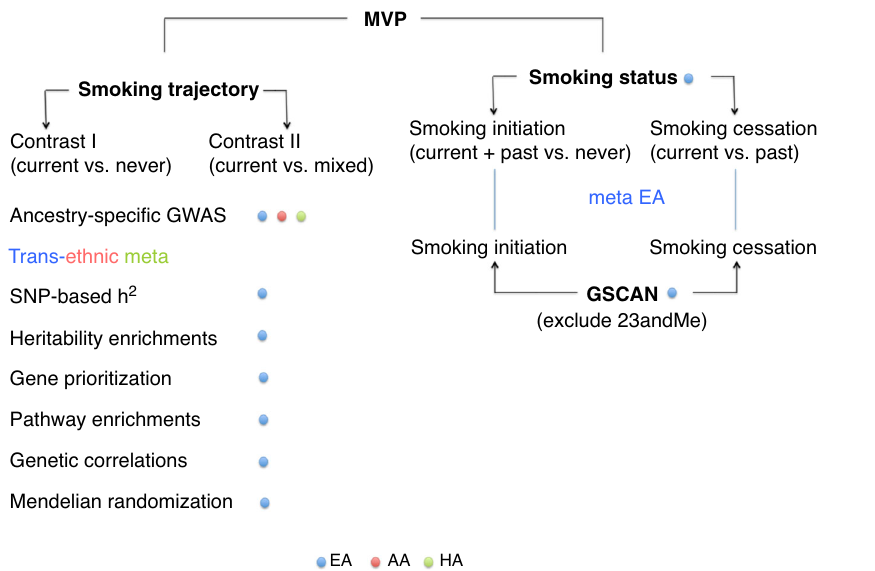
Fig. 1 An overview of analyses performed on the smoking trajectory and status phenotypes. MVP the Million Veteran Program; GSCAN the GWAS & Sequencing Consortium of Alcohol and Nicotine use; EA European American; AA African American; HA Hispanic American; GWAS genome-wide association study; h 2